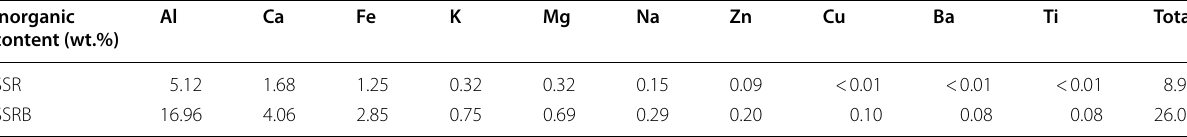
Table 1 Inorganic contents in the SSR and SSRB as measured by ICP‑OES analysis Inorganic content